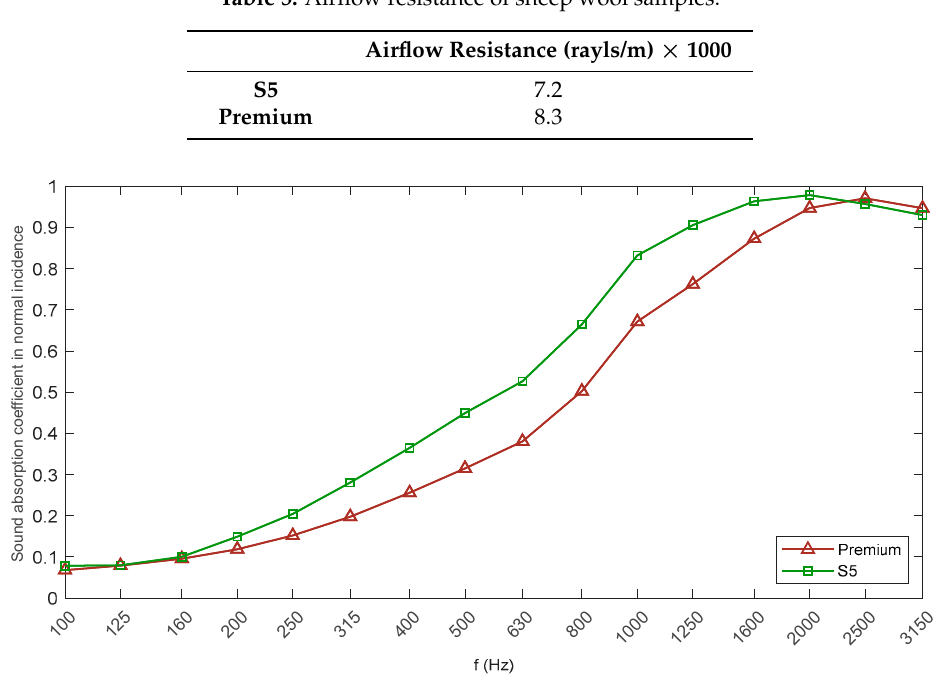
Table 5. Airflow resistance of sheep wool samples.